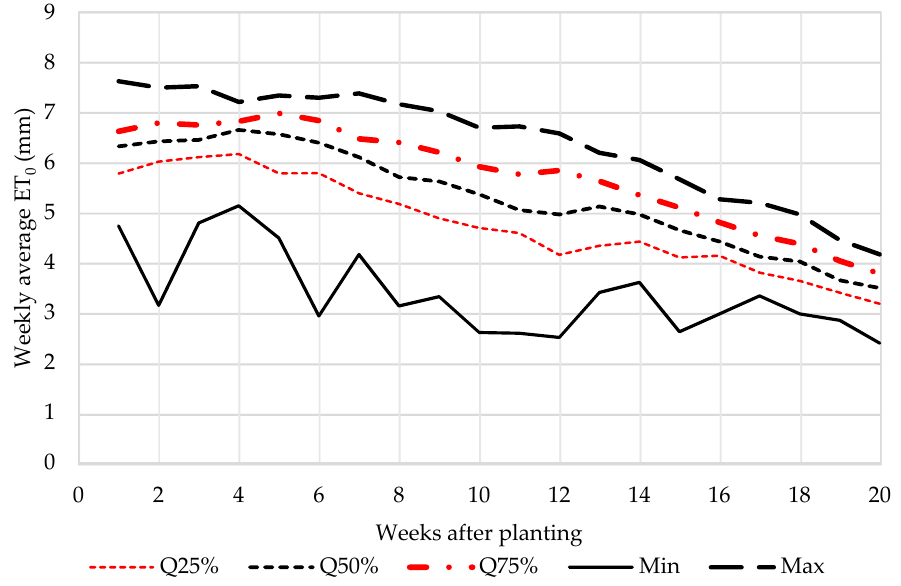
Figure 1. Weekly average daily reference evapotranspiration (ET 0 ) for quantiles 25% (Q25%), 50% (Q50%), 75% (Q75%), minimum (Min), and maximum (Max) in Vaalharts.